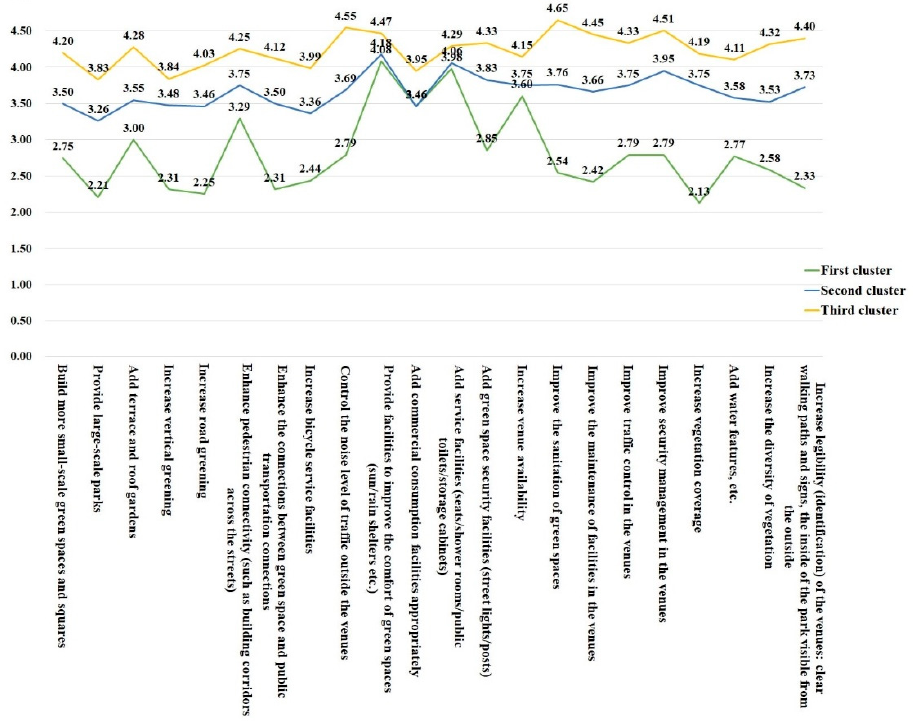
Figure 6. Mean analysis of subjective evaluation factors in different clusters.